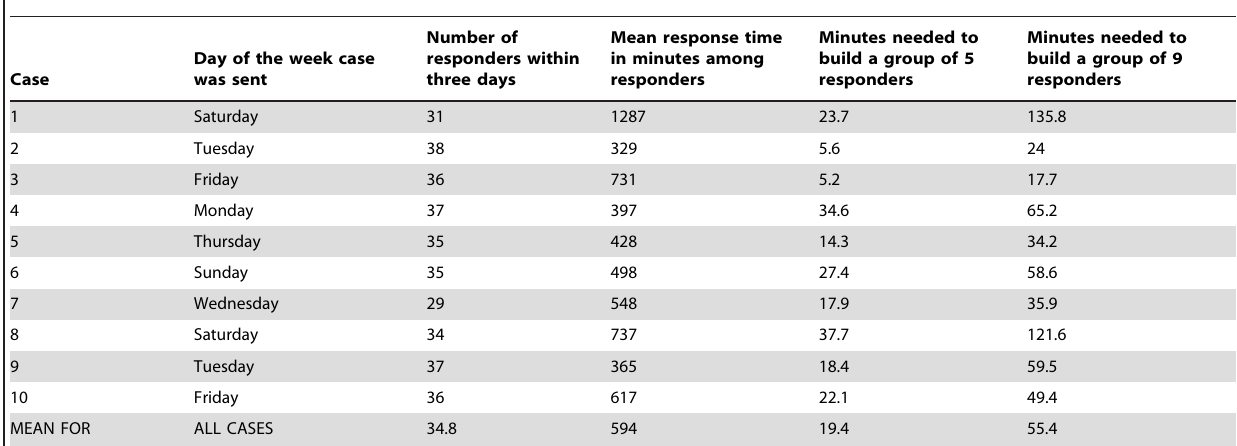
Table 3. Response time to 10